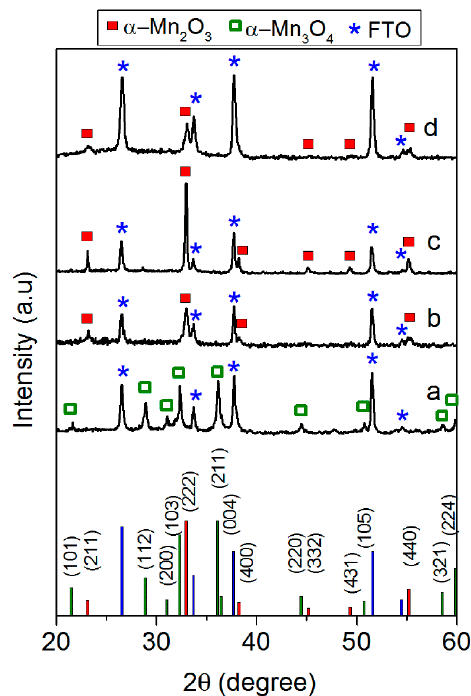
Figure 2. XRD patterns of Mn 3 O 4 -SC ( a ); Mn 2 O 3 -SC ( b ); Mn 2 O 3 -SC-TT ( c ) and ED 5c ( d ) films. Indices